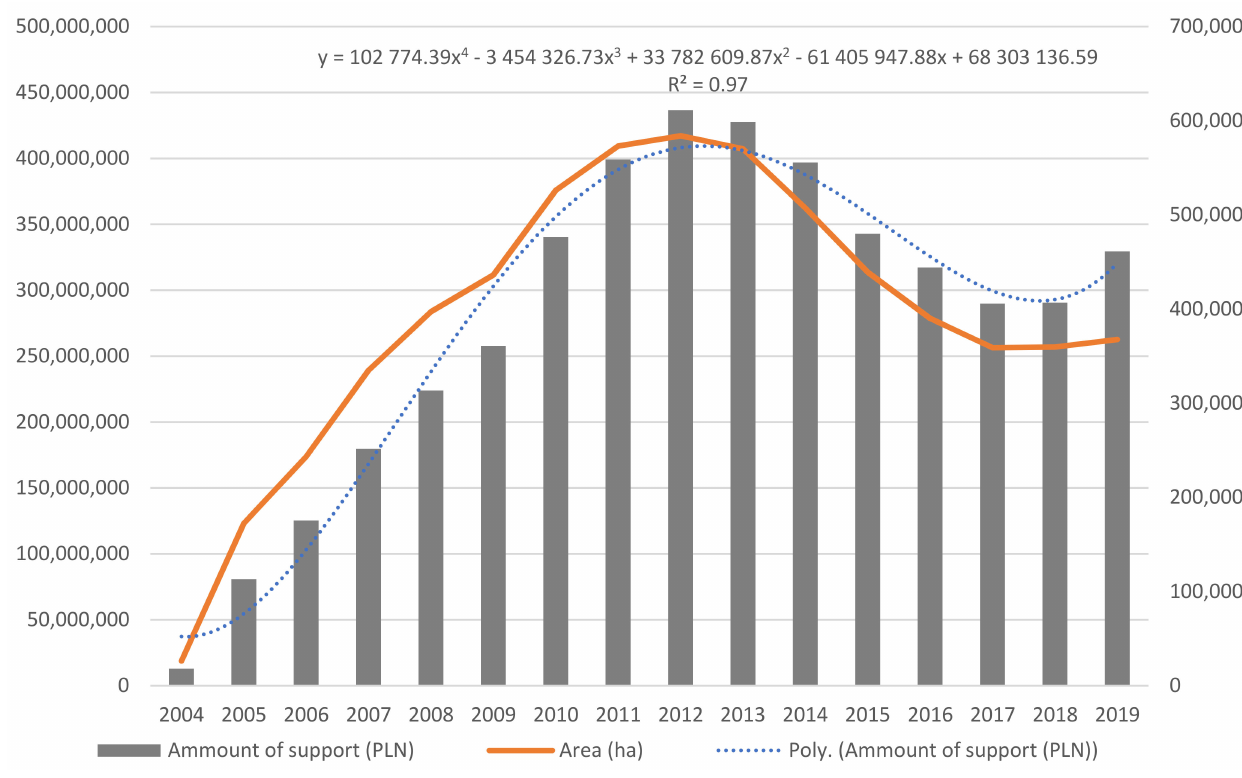
Figure 4. Amount of organic farming support and organic farming area covered by support under the 2004–2019. Source: own compilation based on